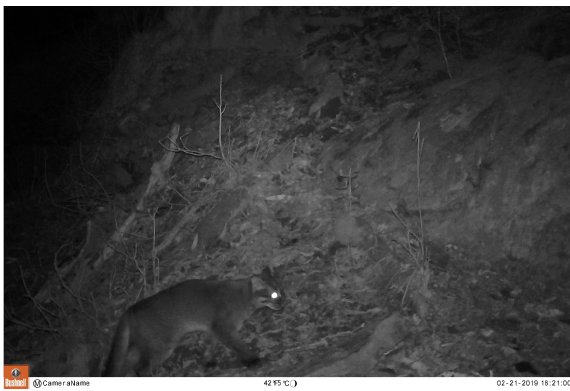
Image 1. Asiatic Golden Cat recorded in Gaurishankar Conservation Area on 21 February 2019. © Gaurishankar Conservation Area Project,